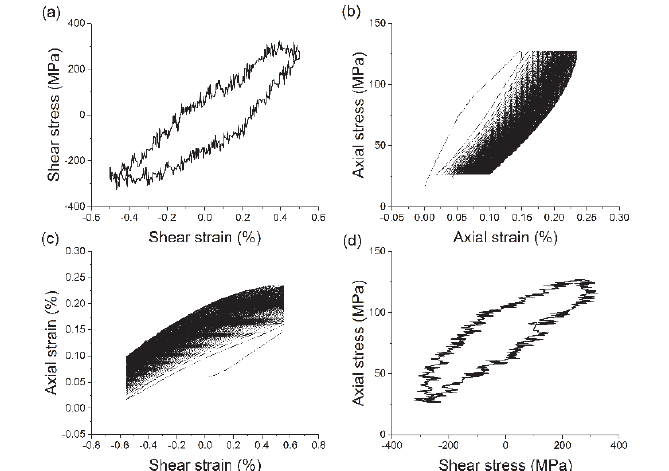
Figure 3: Experimental results of case 4, (a) shear stress-strain curve in cycle 200, (b) axial stress-strain curve, (c) strain path and (d) stress path in cycle 200.